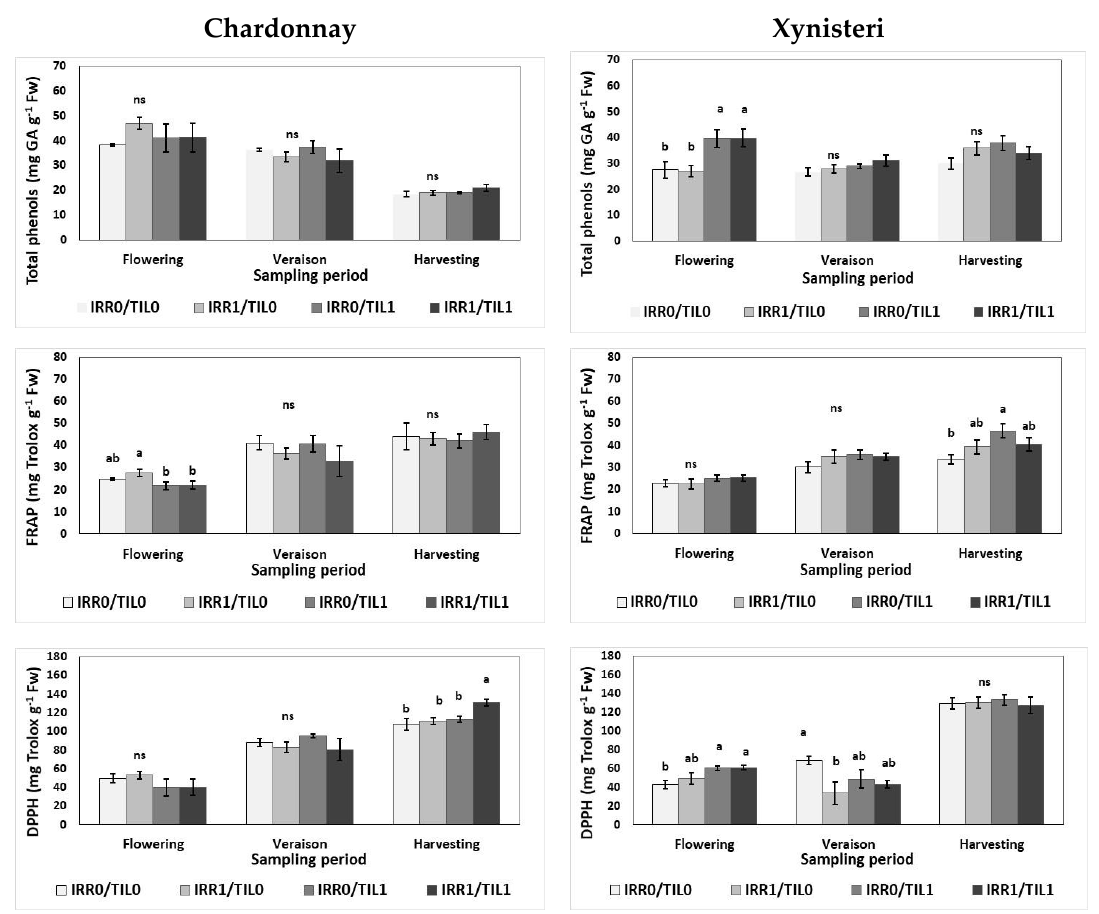
Figure 3. Impact of irrigation and/or cultivation practices (no tillage–tillage) on the content of total phenols and antioxidant activity (FRAP and DPPH) in leaves. Sampling dates were during flowering (1st sampling), veraison (2nd sampling) and harvesting (3rd sampling). Significant differences ( p < 0.05) among treatments are indicated by different letters according to Duncan’s multiple range tests. Error bars show SE ( n = 4). ns: not